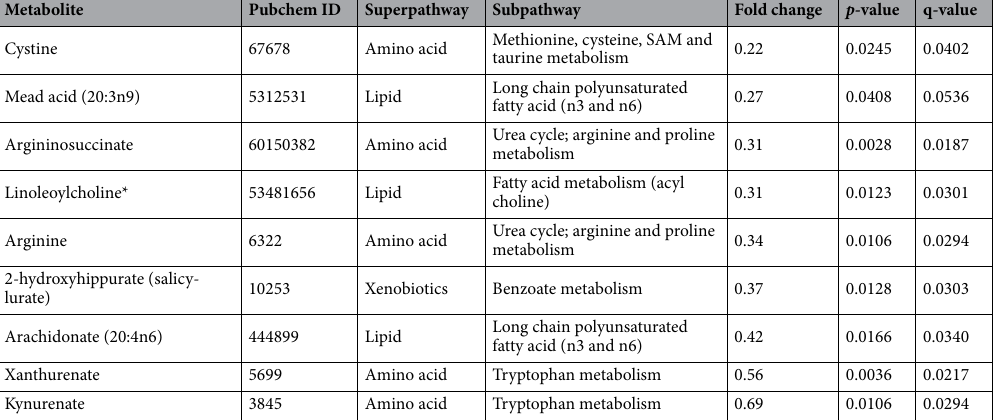
Table 2. Decreased metabolites in the Ahr knockout cover a wide range of biochemical pathways and fold